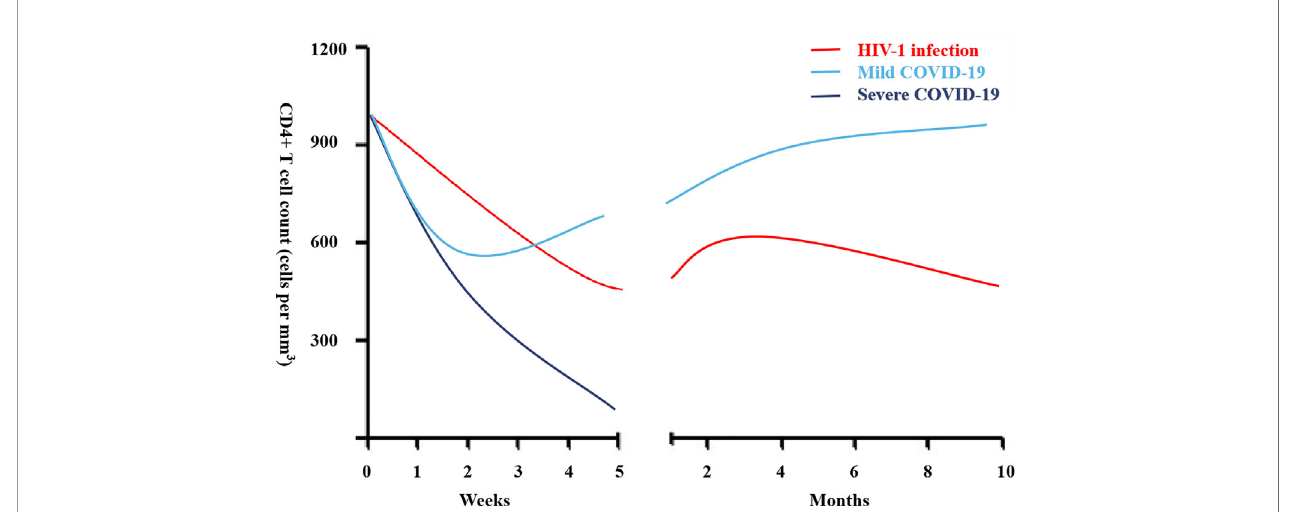
FIGURE 1 | CD4+ lymphocyte count during acute infection in people living with HIV (PLWH) and coronavirus disease-19